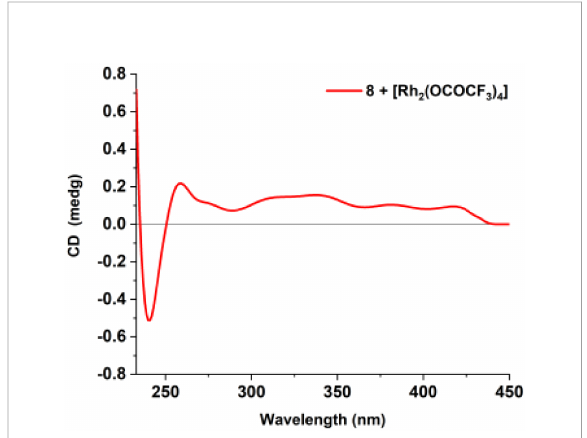
FIGURE 6 ECD spectrum of the [Rh 2 (OCOCF 3 ) 4 ] complex of compound 8 with the inherent ECD spectrum